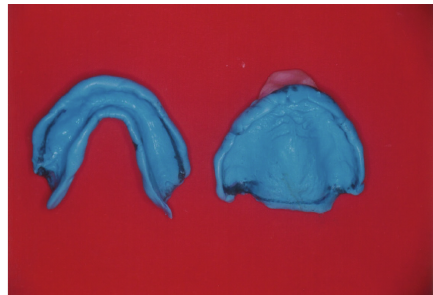
Figure 4: Secondary impression with border moulding.